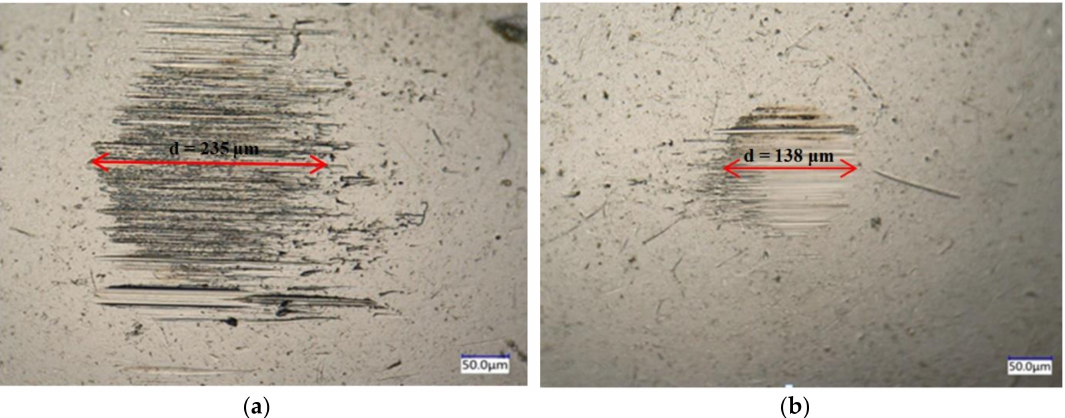
Figure 5. Optical micrographs of wear scars of the steel balls lubricated with ( a ) 5CB and ( b ) 5CB+0.15 wt.%